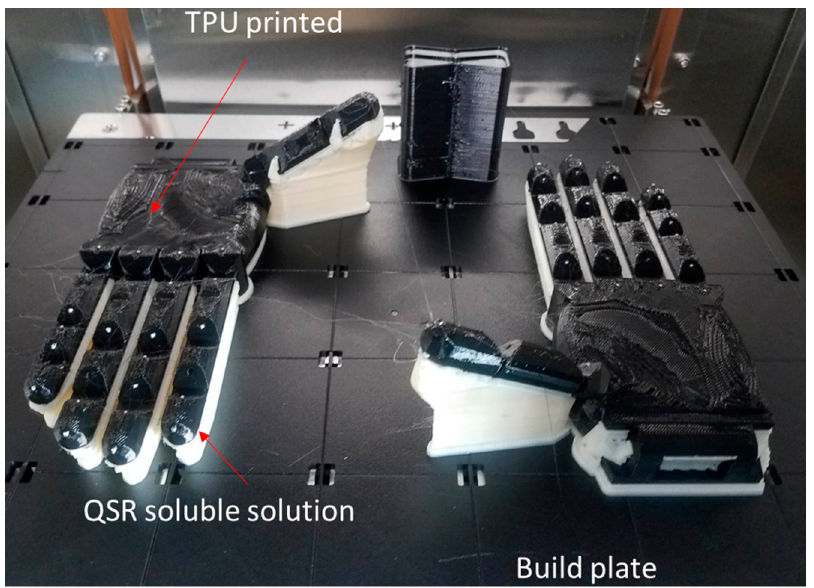
Figure 3. 3D-Printed soft TPU hand using the Stratasys F370 3D printer.